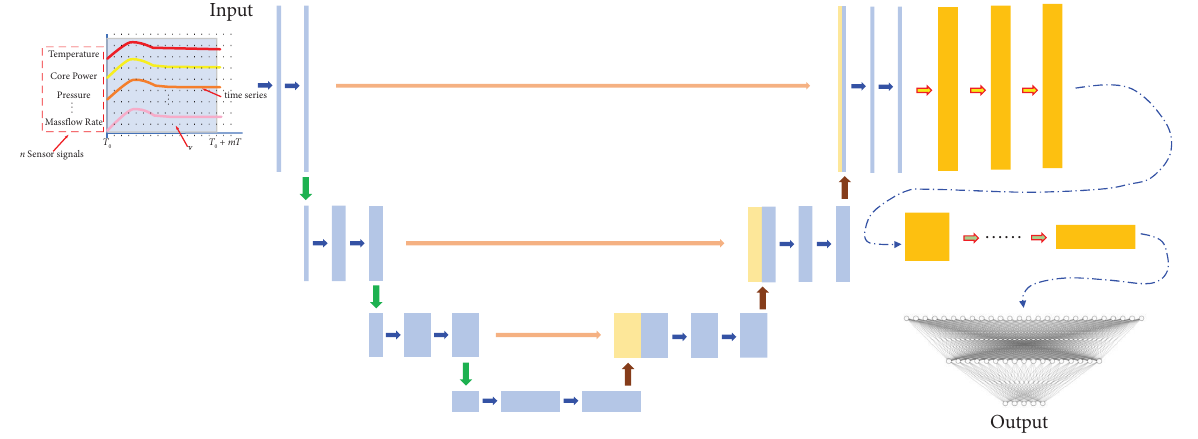
Figure 5: Detailed architecture of EDN-NPSP.